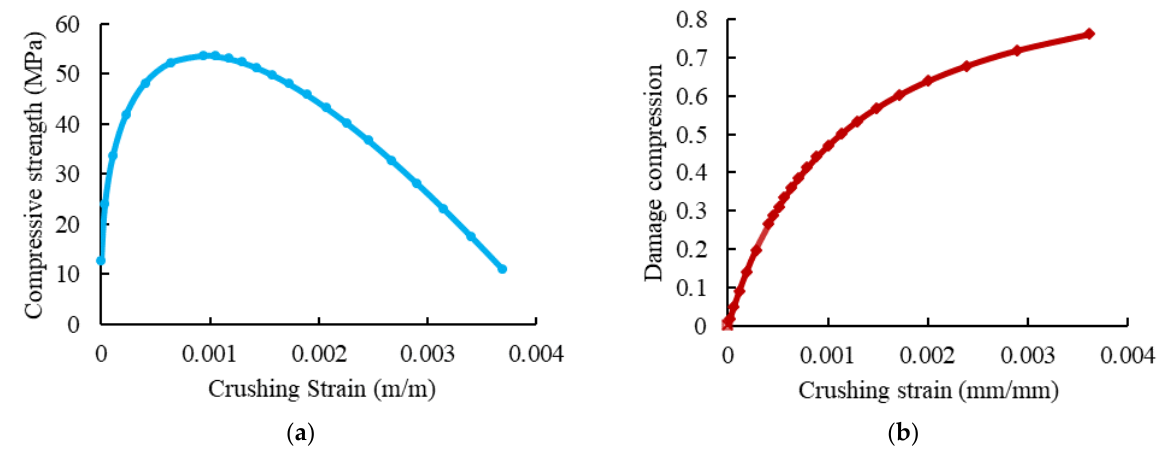
Figure 12. The behavior of concrete under compression. ( a ) Concrete compressive stress-strain curve. ( b ) Compressive damage evolution of concrete.